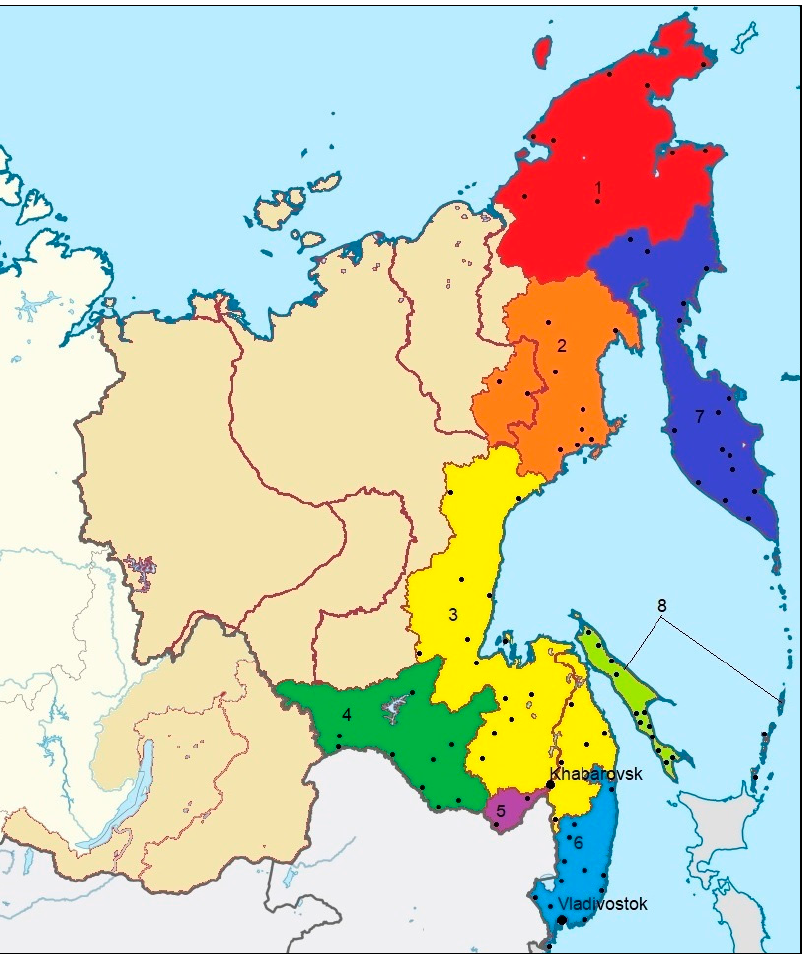
Figure 1. The Far Eastern Federal District (FEFD) of Russia, showing all regions of the study area, as follows: 1—Chukotsky Autonomous Okrug (Chukotka); 2—Magadan Region; 3—Khabarovsky Krai; 4—Amur Region; 5—Jewish Autonomous Region; 6—Primorsky Krai; 7—Kamchatsky Krai; 8—Sakhalin Region. The capital cities of the FEFD are as follows: Khabarovsk (2002–2018) and Vladivostok (2018–present). Black dots show the location of weather stations.